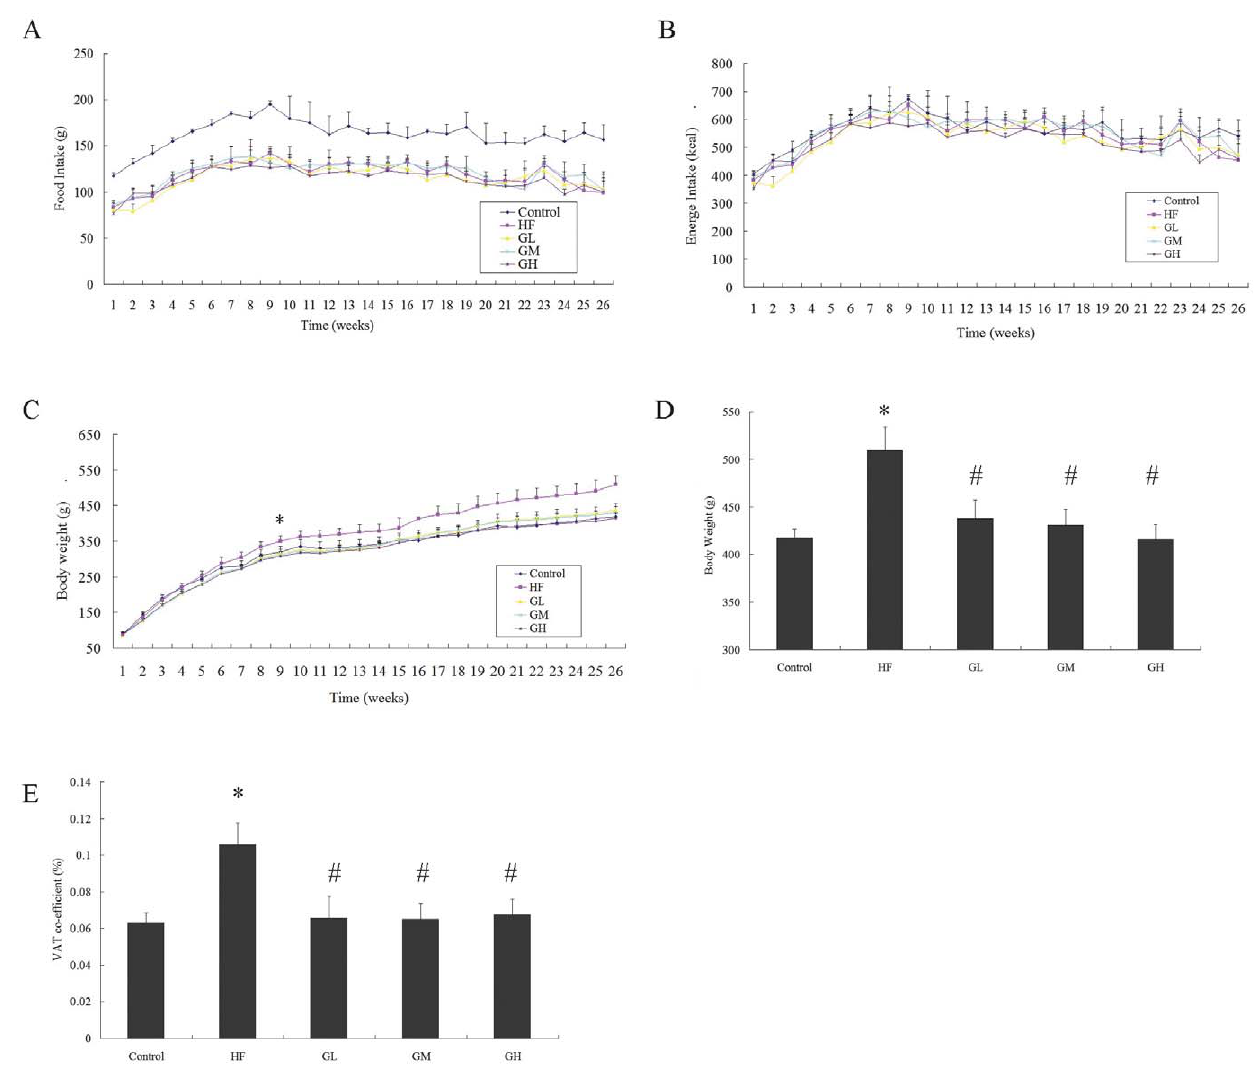
Figure 1. GTPs reduced body weight gain and VAT coefficient induced by HF diet without affecting the energy intake. GTPs treatment did not affect the energy intake in compare with the HF group, although the food intake of the control group is higher than other groups(A), no significant difference was observed in energy intake (B). Difference in body weight started from the 9 th week (C). The body weight was obviously higher in the HF group in compare with all other groups (D); VAT coefficient of the HF group was obviously higher than the control group, and GTPs treatment alleviated the effect (E). (* P , 0.05 vs. the control; # P , 0.05 vs. the HF group). Data is expressed as the mean 6 SEM (N=6).